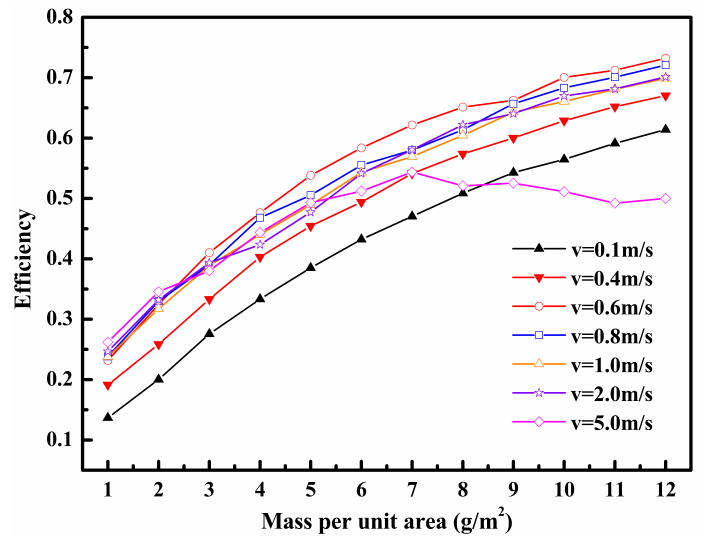
Figure 13. Influence of inlet velocity on filtration efficiency.